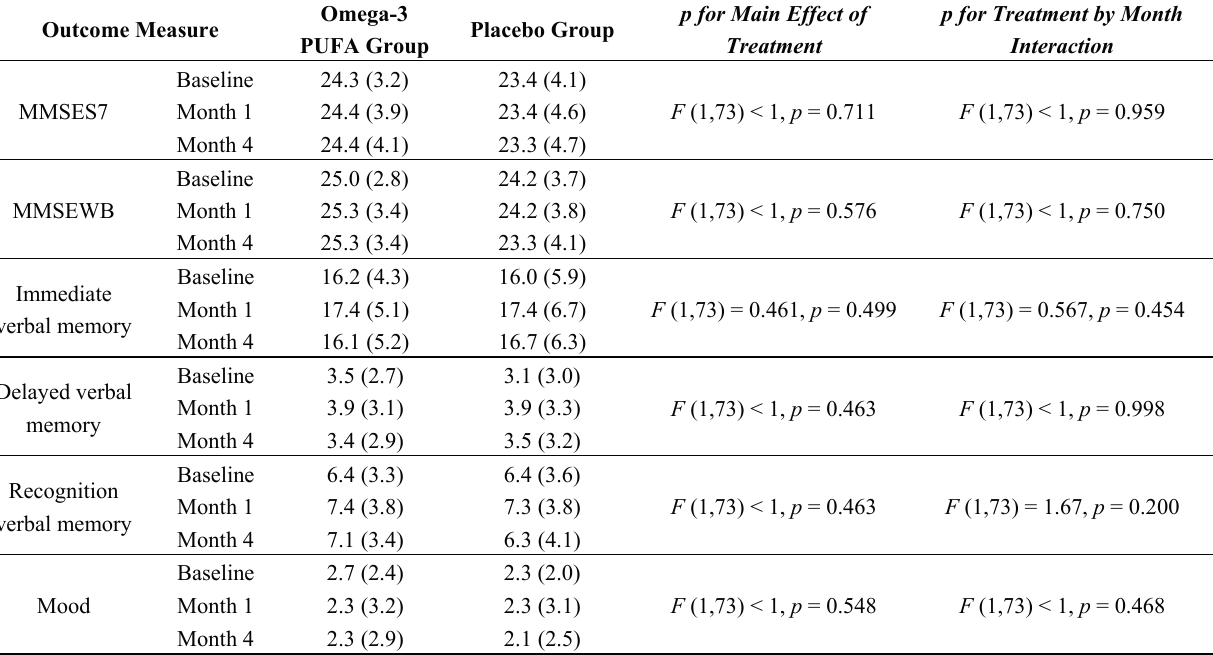
Table 2. Primary outcome measure performance scores over the study duration. Data are mean (SD). Baseline scores were included as a covariate in the analyses of the effects of treatment and treatment by month. MMSES7, mini–mental state examination Serial Sevens; MMSEWB, mini–mental state examination World Backwards; PUFA, polyunsaturated fatty